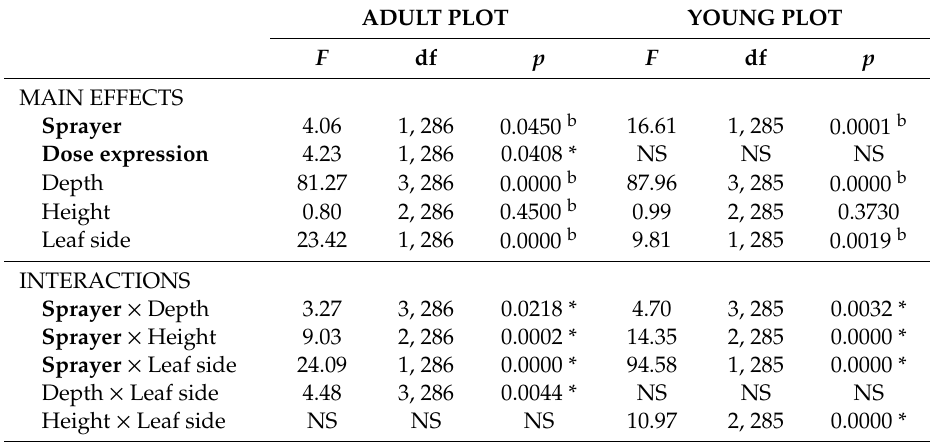
Table 7. Multifactor analysis of variance (ANOVA) results for the coverage (%) in the adult and the young plots. The main study factors have been highlighted in bold (least significant di ff erence (LSD) test, p < 0.05) a